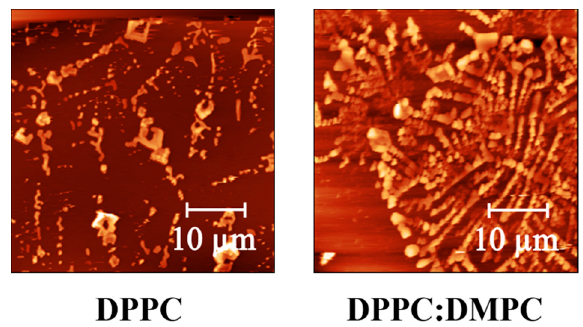
Figure 5. Atomic Force Microscope (AFM) micrographs of the samples DPPC and DPPC:DMPC (2:1), respectively.